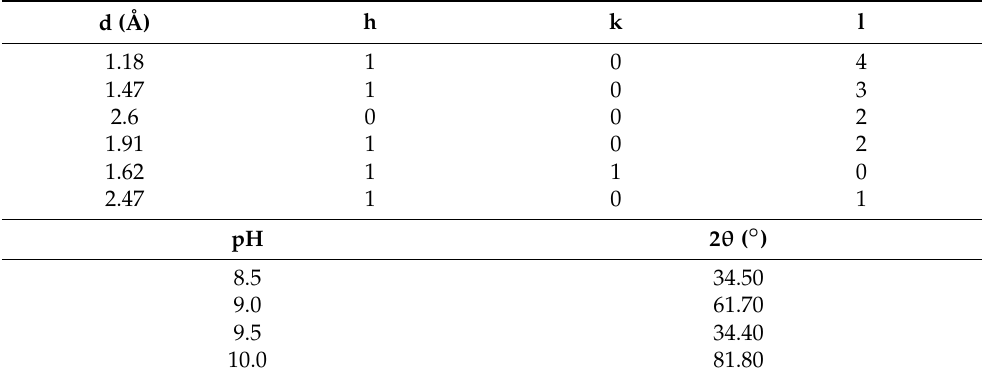
Table 1. Table list of some (h, k, and l) and 2 θ for ZnO samples.